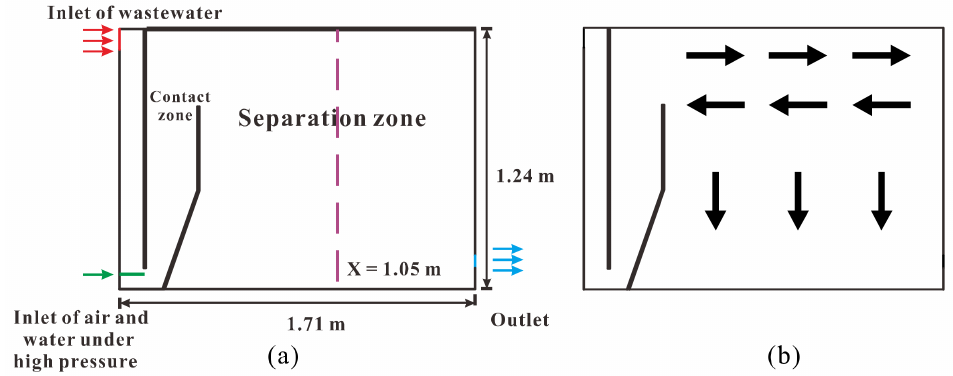
Figure 1. ( a ) Geometry of the FAF and DAF tank, ( b ) velocity profile of separation zone in DAF